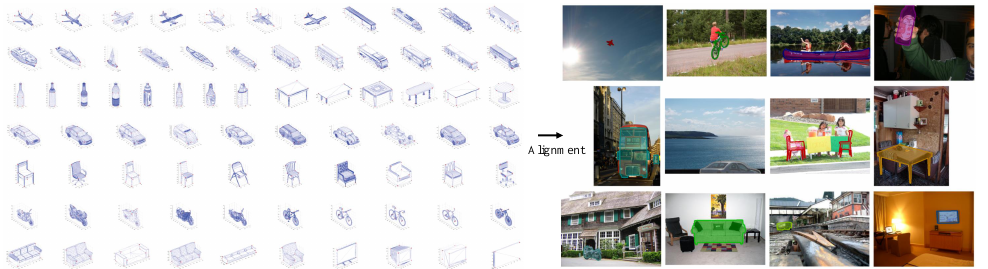
Figure 2. PASCAL3D+ [31] for 3D object detection and pose